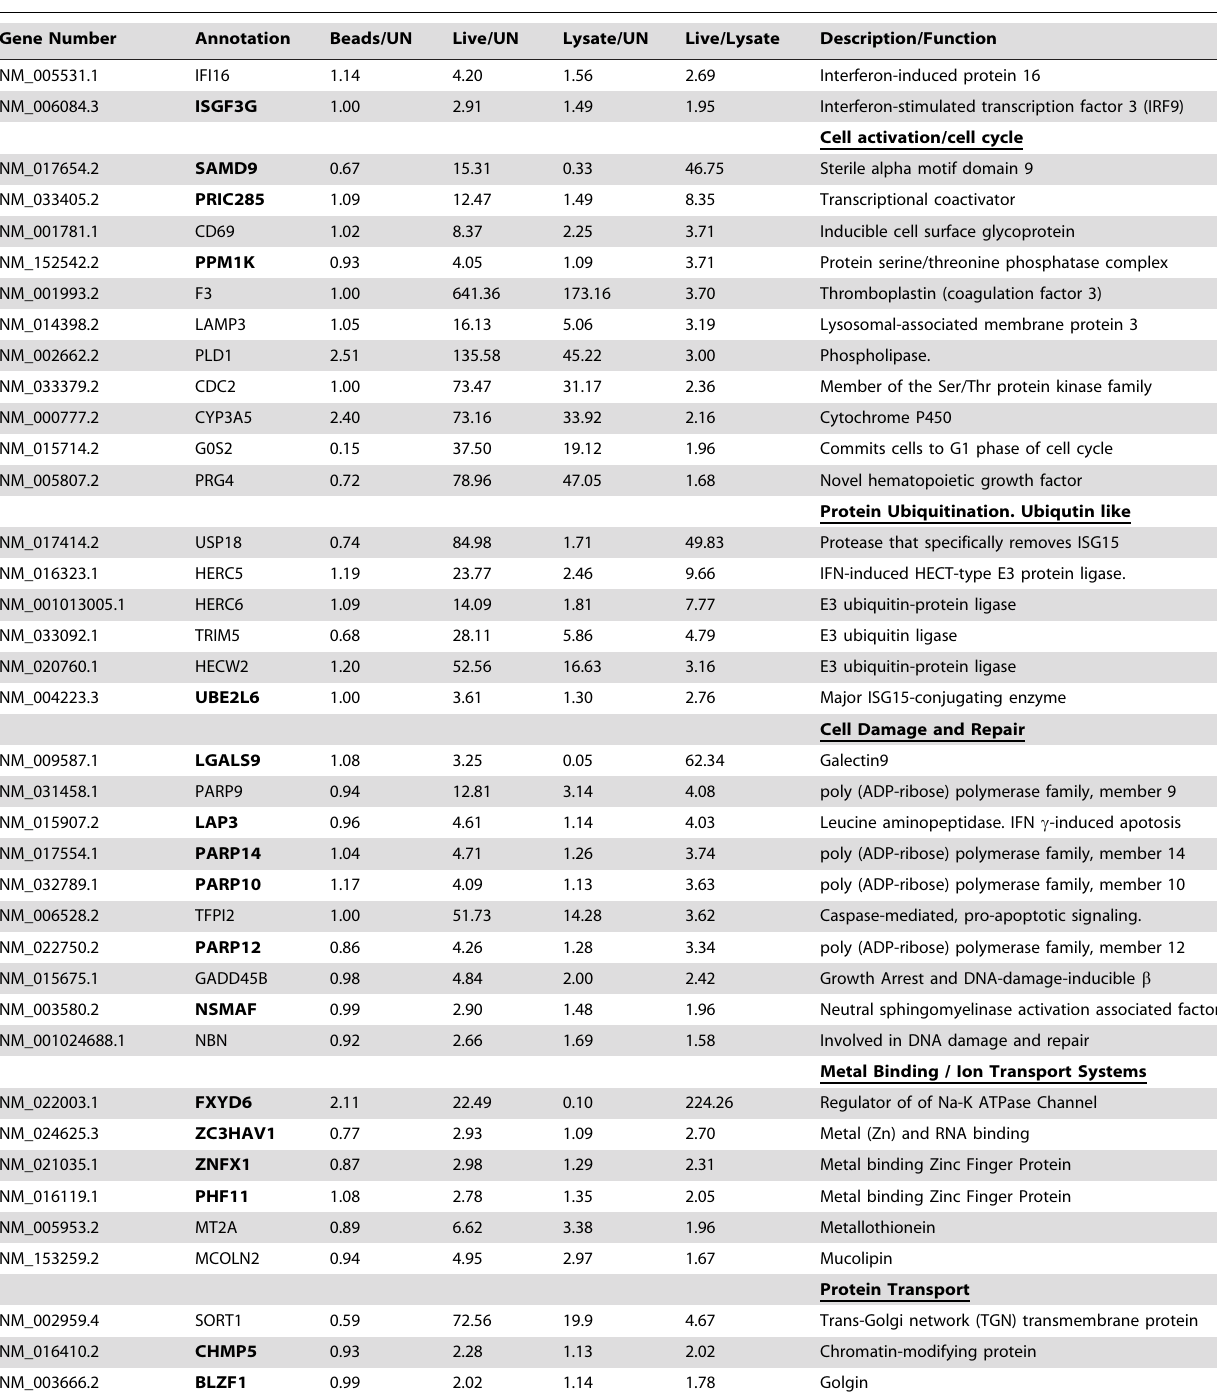
Values shown correspond to a ratio determined between normalized gene intensity values obtained after a four-hour PBMC stimulation with either inert beads, live or lysed Bb (MOI 10:1) in proportion to gene intensity values from unstimulated cells. Annotated names in bold letters correspond to genes that were exclusively up- regulated by live Bb.